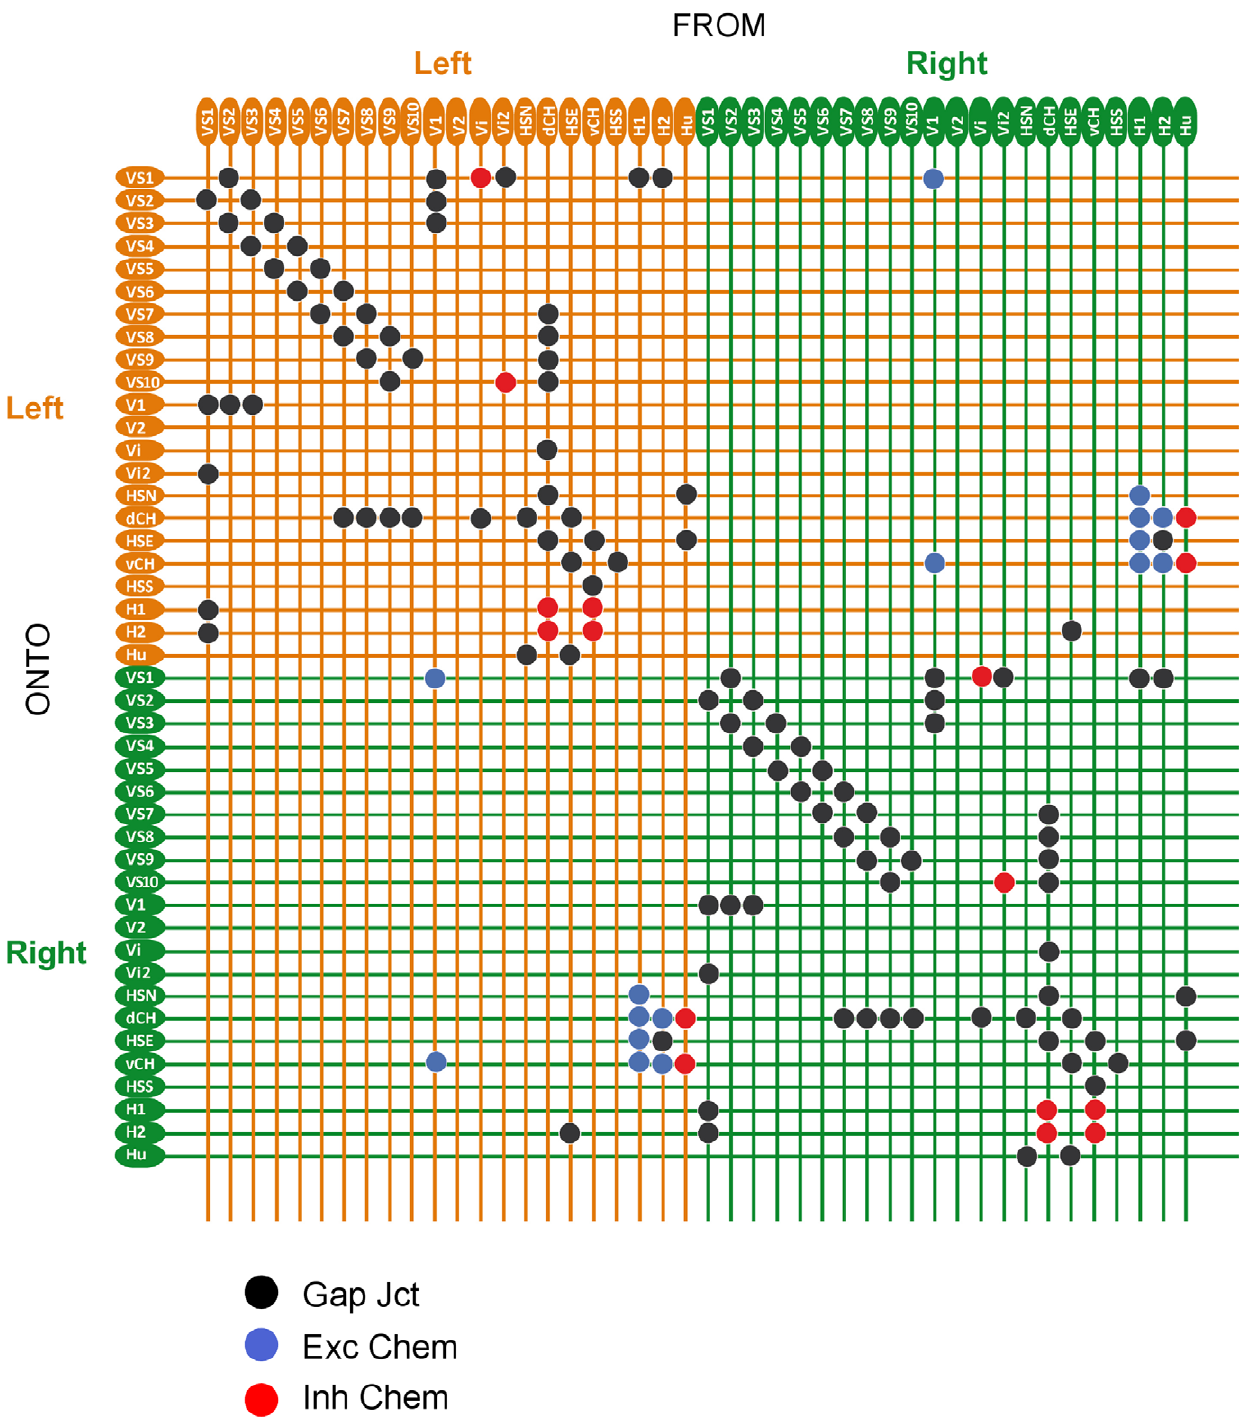
Figure 12. Connectivity matrix of the lobula plate network. The matrix visualizes how the tangential cells within one lobula plate and between the left and right lobula plate are connected. All cells are listed along the rows and columns. A coupling between the cell in row i and the cell in column j is indicated by a dot at the intersection of row i and column j. The coloring of the dots depicts the type of connectivity (black – gap junction, blue – excitatory chemical synapse, red – inhibitory chemical synapse; see legend). doi:10.1371/journal.pone.0016303.g012 point Q i . The vector d i also describes the direction where Q i is located. When the fly moves, the point at position Q i is displaced with respect to the sphere which, in turn, also changes d i , the projection of Q i onto the sphere.